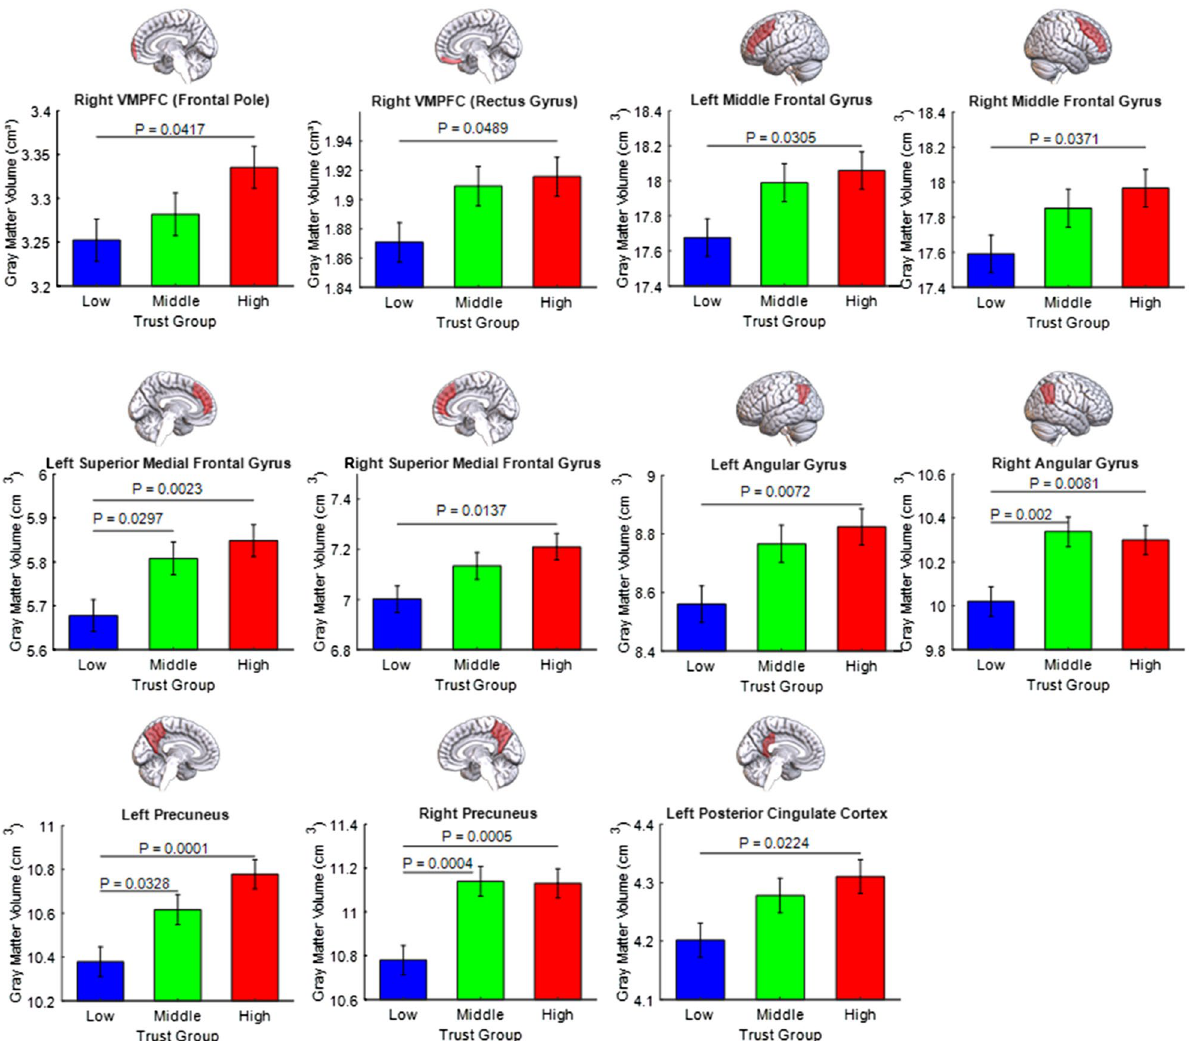
Figure 2. Reduced volume of social brain regions among low trusters. Social brain regions positively associated with trust (Table 1) also showed robust group differences when participants were classified as low trusters, middle trusters and high trusters. Population marginal means and error bars (standard error) were calculated with ANCOVA and all P-values are Bonferroni corrected for multiple comparisons. Gray matter volume is adjusted for age, sex, education, income and